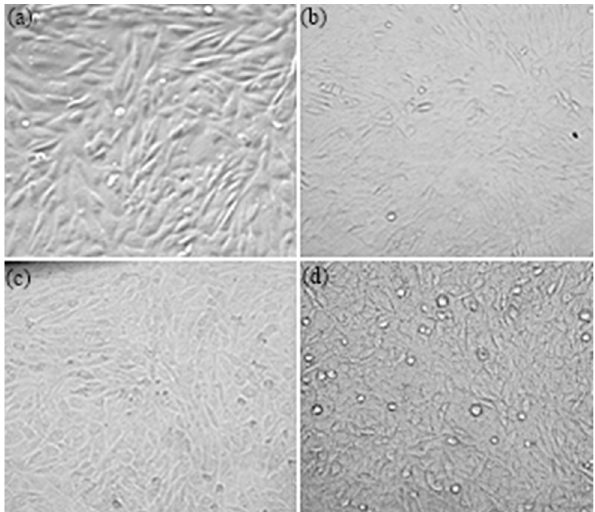
Figure 8. The morphology of MG63 (ATCC CRL1427) cells grown in the presence of the thin films (visible, 200×); control MG63 (ATCC CRL1427) cells ( a ), HAp ( b ), 0.05 AgHAp ( c ), and 0.1 AgHAp ( d ).